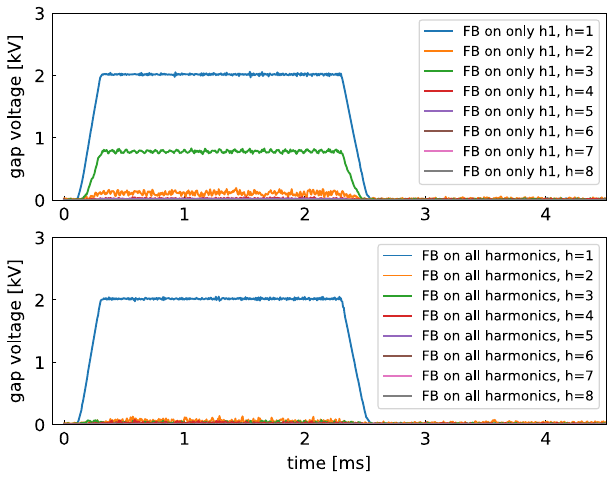
FIG. 25. Harmonic components of the gap voltage (top) when only the feedback for ( h ¼ 1 ) is closed and the other harmonics ( h ¼ 2 … 8 ) are open. (Bottom) With the feedback loops closed for all